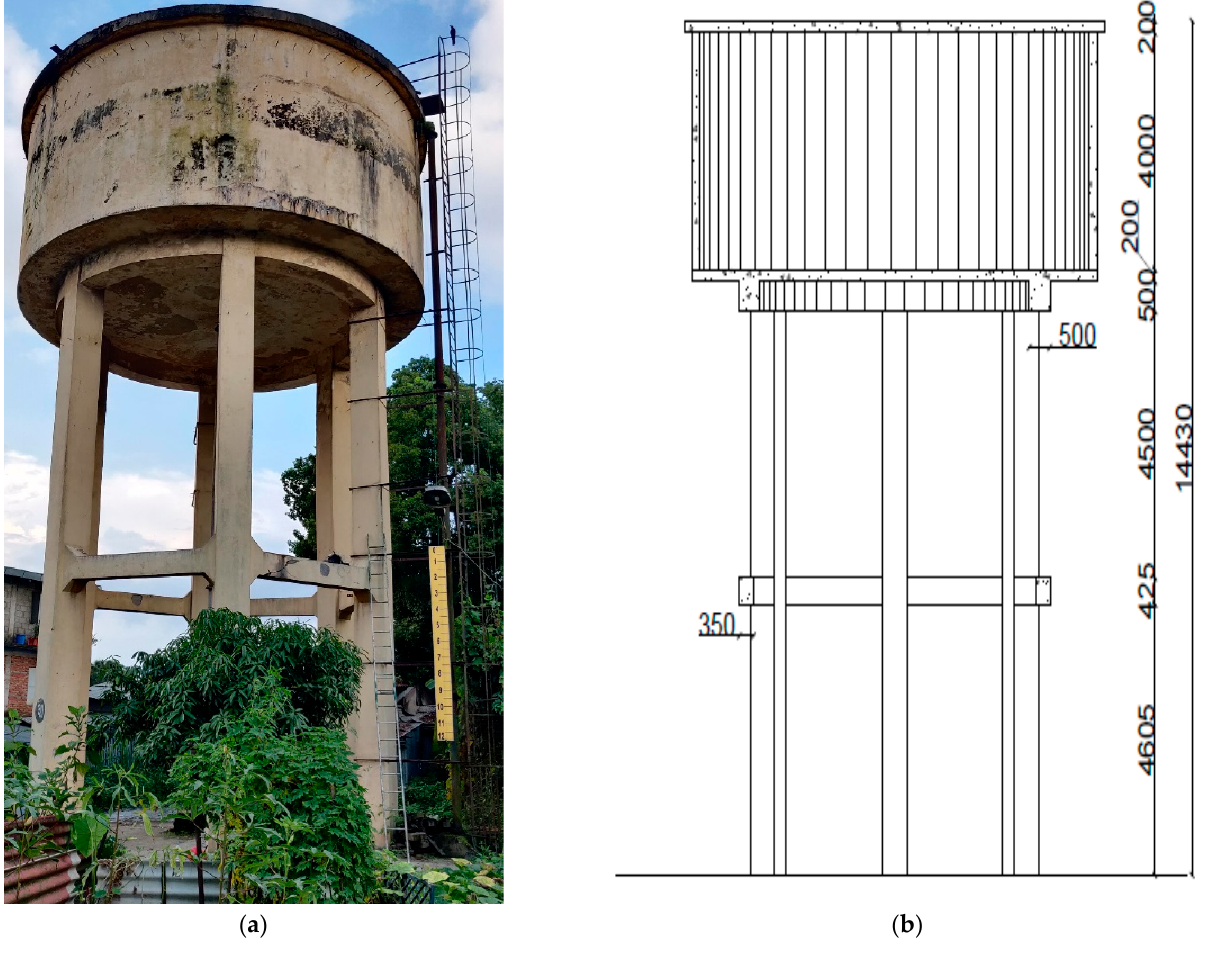
Figure 1. Case study tank: ( a ) existing, ( b ) geometry of the tank (all dimensions are in mm).